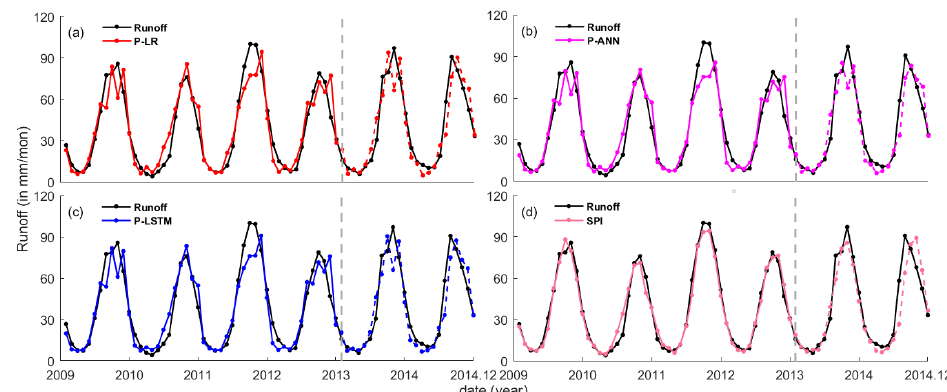
Figure 6. Reconstructed (solid line) and predicted (dash line) runoff at TC–CD station pair, based on remotely sensed precipitation ( P ) averaged over the whole upstream area from Tibetan Plateau to southern boundary of Cambodia via ( a ) linear regression (LR), ( b ) ANN, ( c ) LSTM, and ( d ) data standardization.